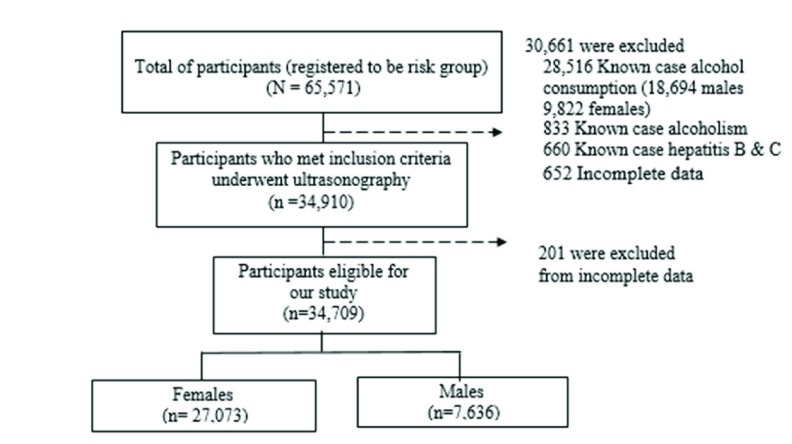
Flow of participants in the Cholangiocarcinoma Screening and Care Program.